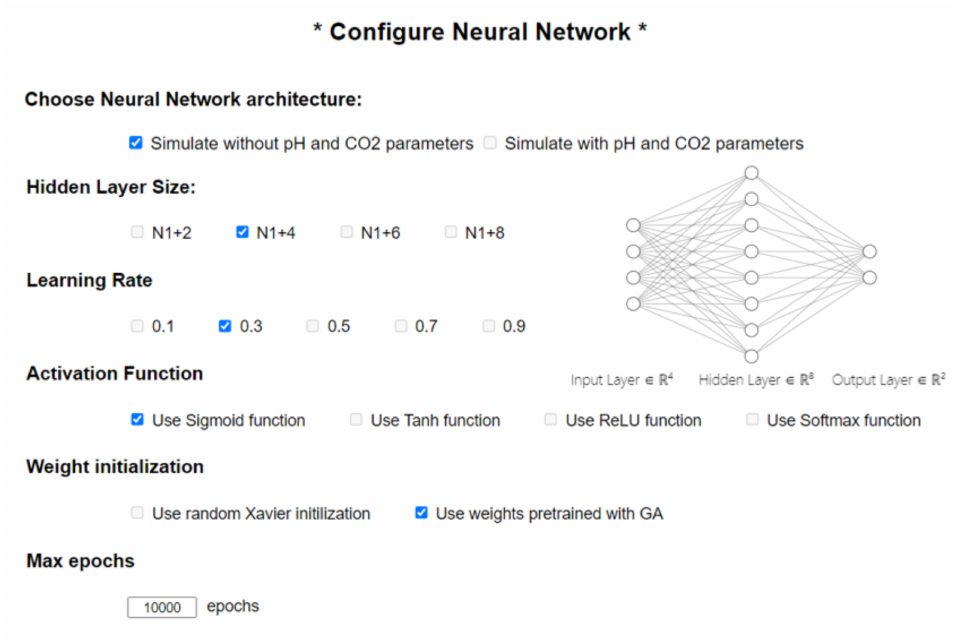
Figure A1. Neural network configuration